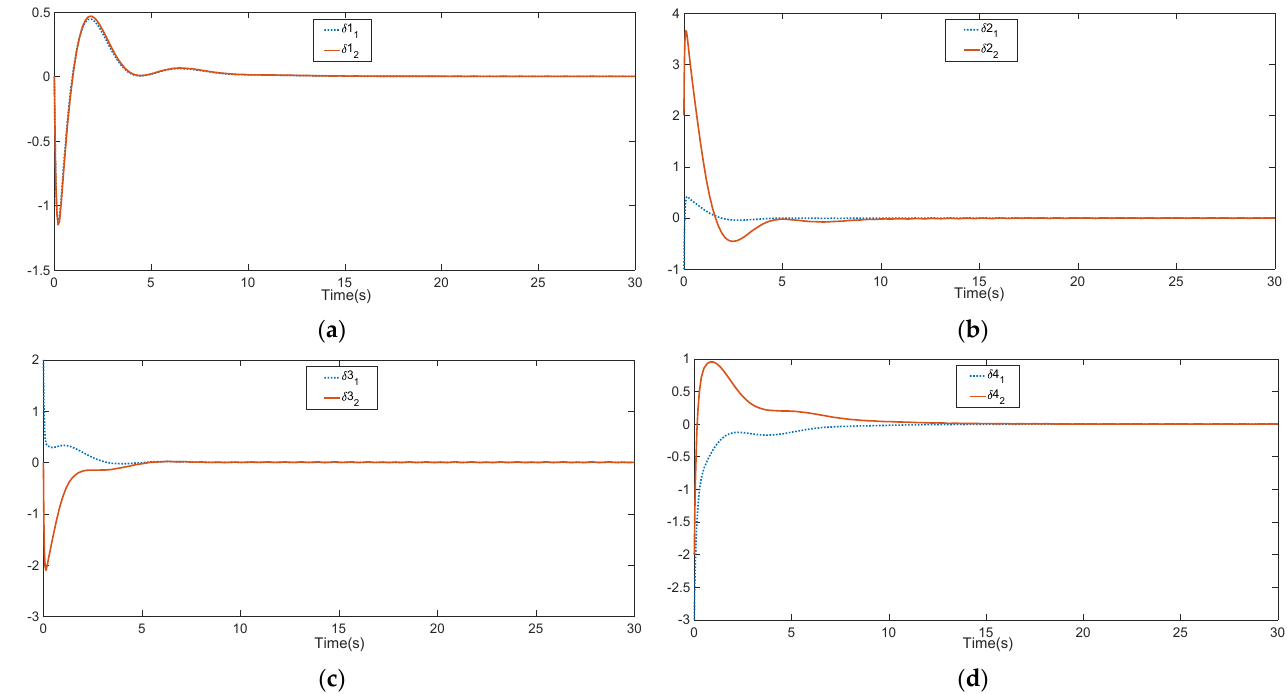
Figure 2. The local neighborhood error vector of each agent: ( a ) The node 1 agent; ( b ) The node 2 agent; ( c ) The node 3 agent; ( d ) The node 4 agent.